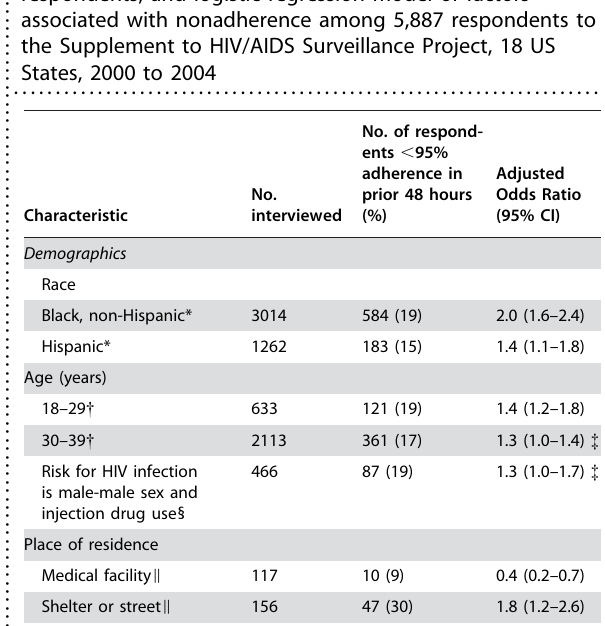
Table 2. Characteristics of HIV infected persons interviewed about adherence to currently prescribed antiretroviral therapy, number and proportion of nonadherent respondents, and logistic regression model of factors associated with nonadherence among 5,887 respondents to the Supplement to HIV/AIDS Surveillance Project, 18